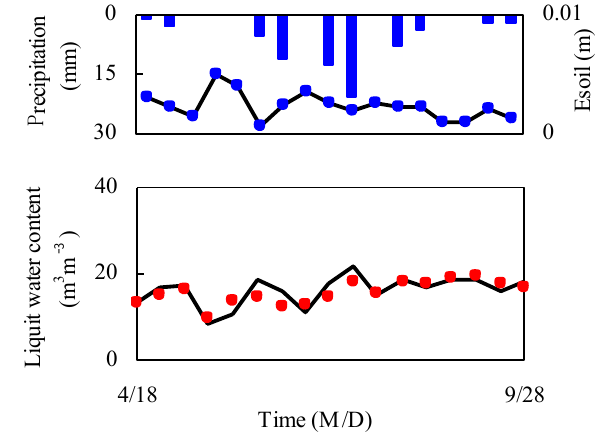
Figure 5: With the observed precipitation (blue bar) and simulated evaporation (black solid line with blue circle) at the corresponding time, comparison between simulated (black solid line) and measured (red dotted line) results for soil liquid water content at 50 cm depth in 2005.